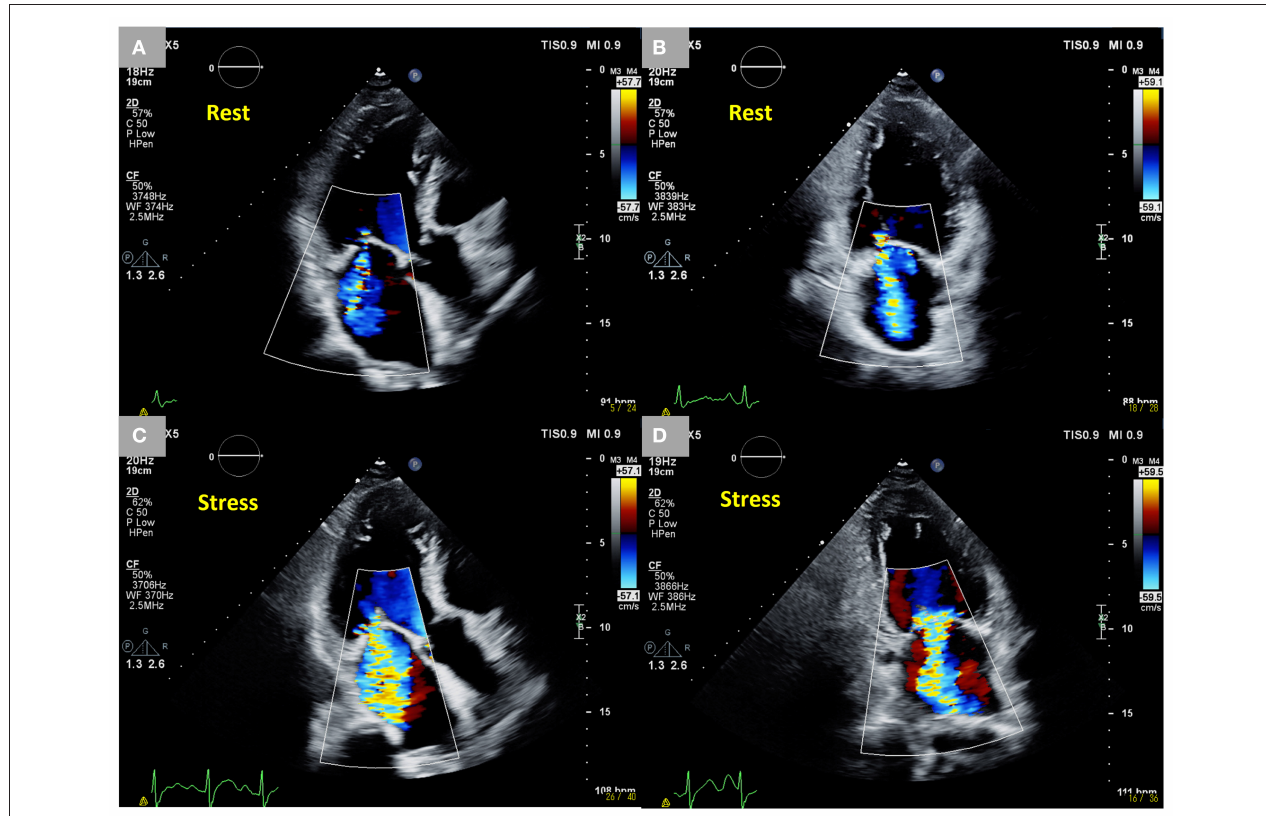
FIGURE 2 | Dynamic changes in SMR during exercise stress echocardiography in an 85-year-old male patient who had an anterior old myocardial infarction and heart failure with reduced ejection fraction. Moderate SMR (EROA 0.22 cm 2 ) at rest. (A,B) Two-dimensional color Doppler images from three- and two-chamber views. Dynamic severe SMR (EROA 0.46 cm 2 ) under stress. (C,D) Two-dimensional color Doppler images from three-chamber and two-chamber views. SMR, secondary mitral regurgitation; EROA, effective regurgitant orifice area.